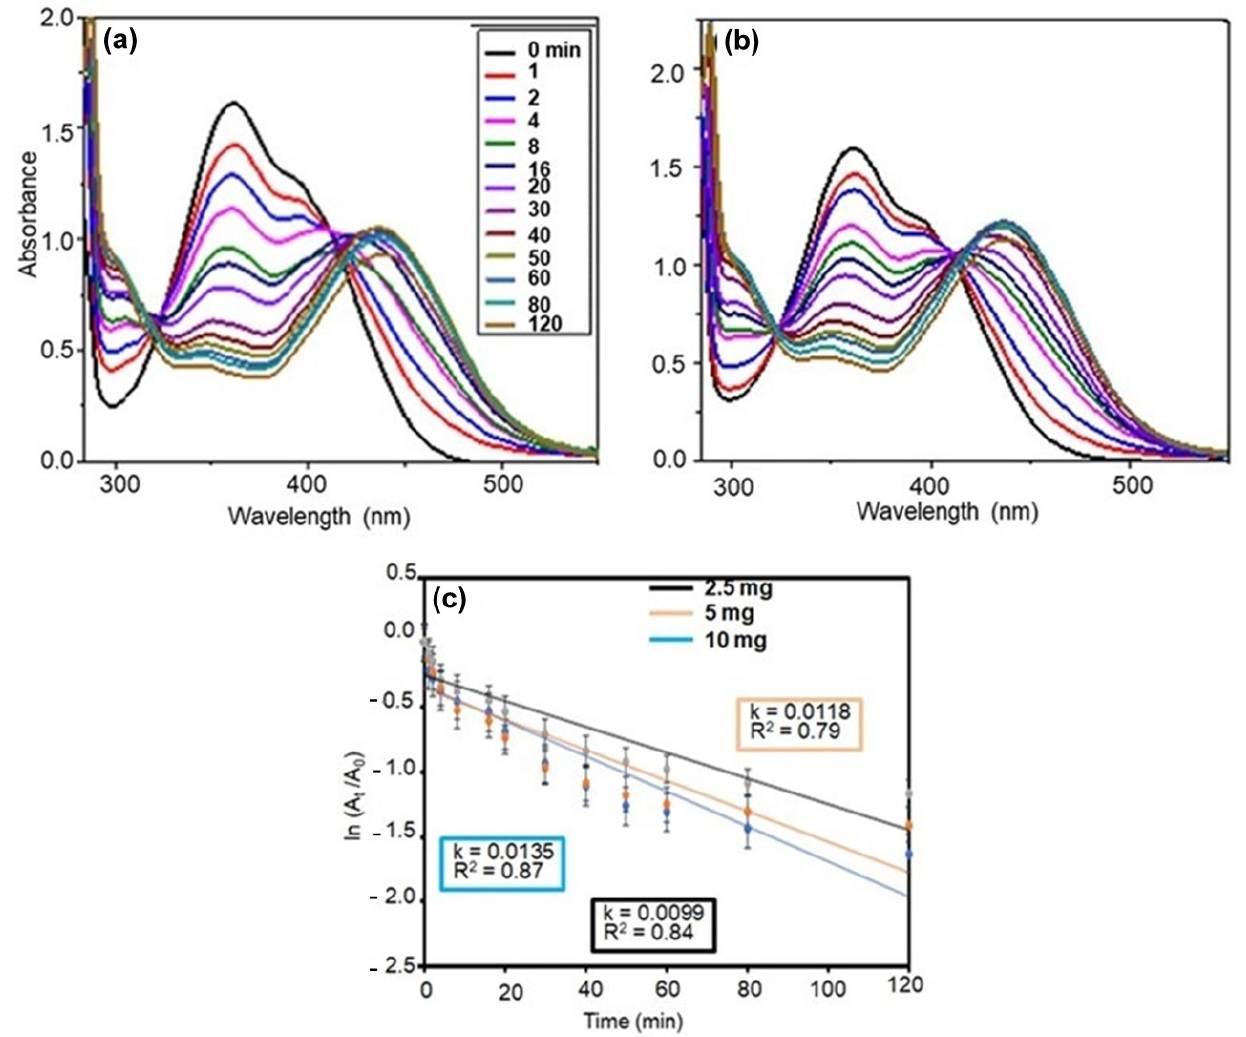
Figure 8. UV-Vis absorption spectra for the reduction of 2,4-DNP over Ag NPs@GO-FL-CS 200 using ( a ) 5 mg and ( b ) 10 mg; ( c ) The corresponding kinetics graphs.